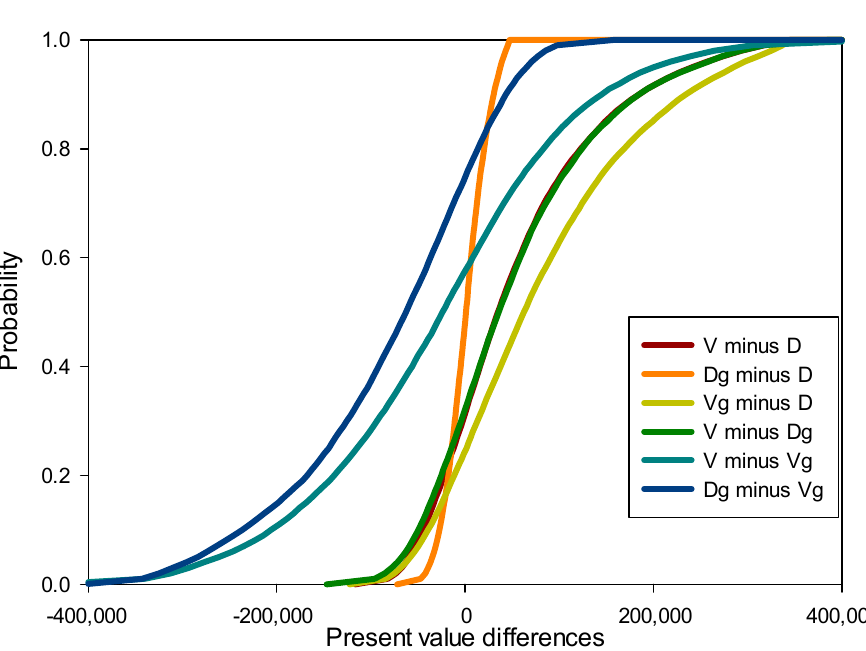
Figure 7. Comparisons per pairs of updated values obtained (V = NPV, D = DNPV, g = gamma discount function).